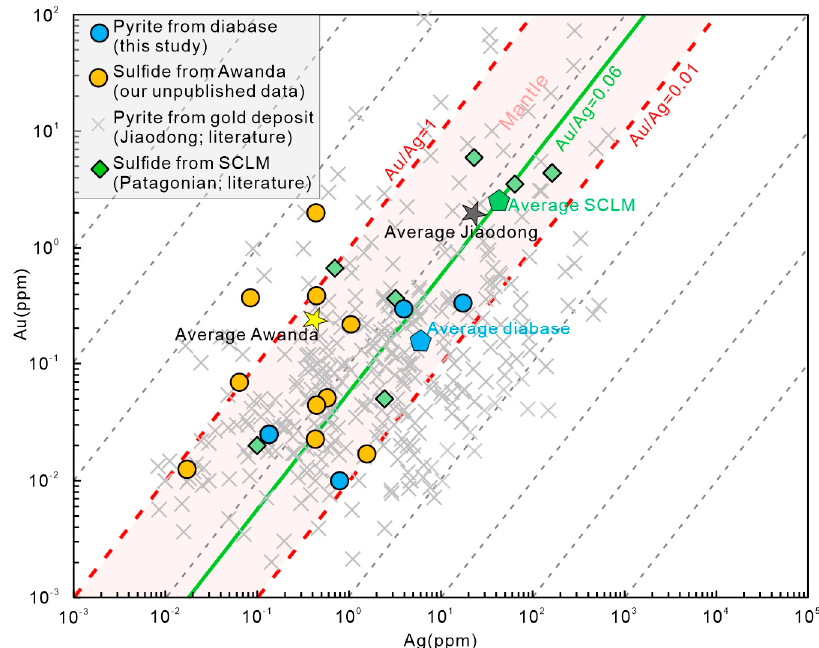
Figure 8. Au versus Ag contents of pyrite from the Aksu Neoproterozoic diabase dykes and lode gold deposits in Chinese South Tianshan. Dotted lines are constant Au/Ag ratios. Data sources: mantle sulfides [6]; Jiaodong gold deposits [63–70]; Awanda gold deposits (our unpublished data). Literature data are compiled in Supplementary Table S4.